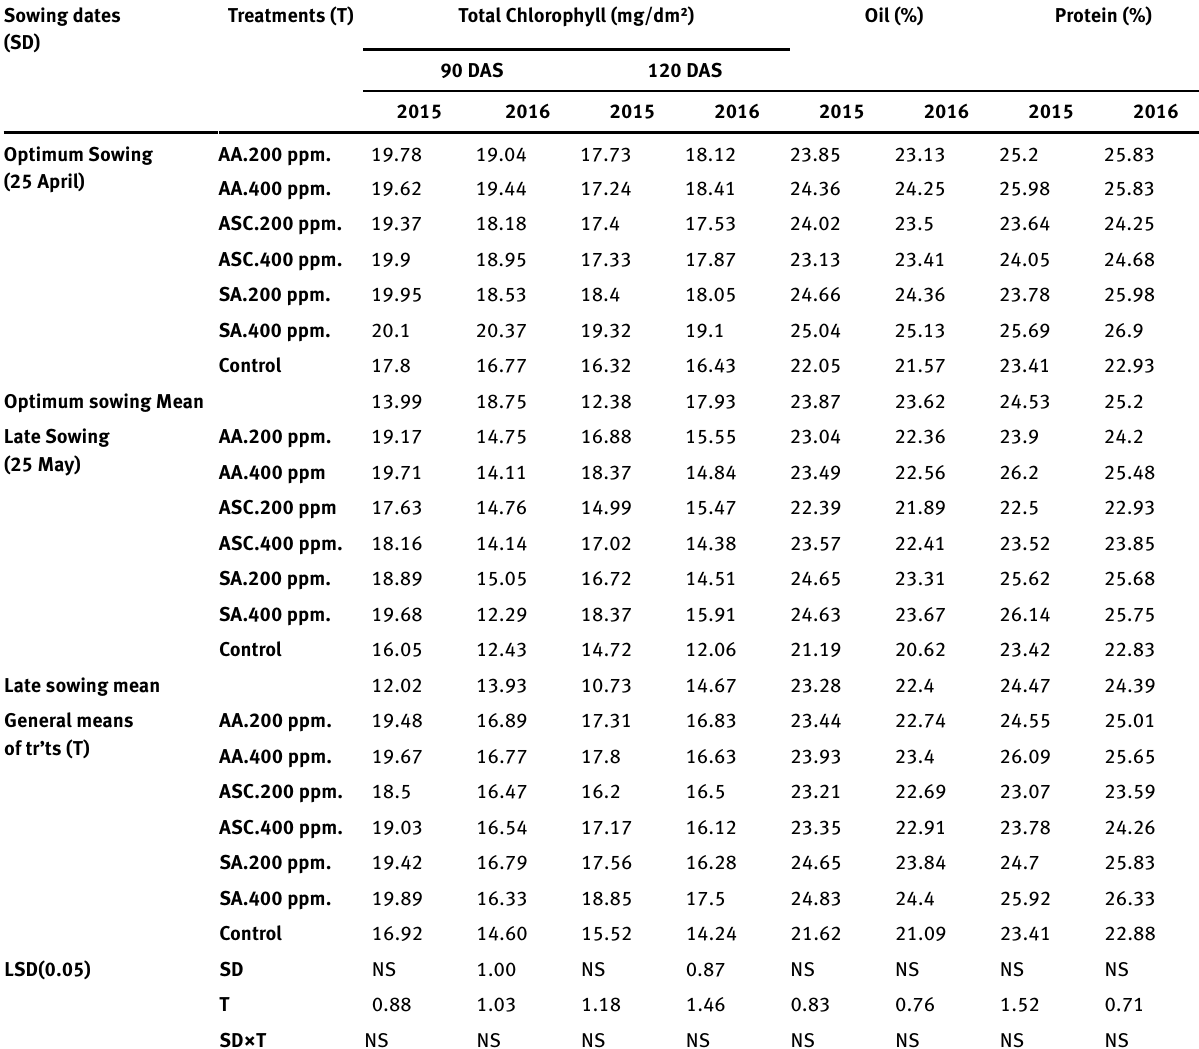
Table 7: Total Chlorophyll content, oil (%) and protein (%) in cotton seeds as influenced by foliar applications of ascorbic acid, ascobine and salicylic acid under optimum and late sown heat stress condition in both the years Sowing